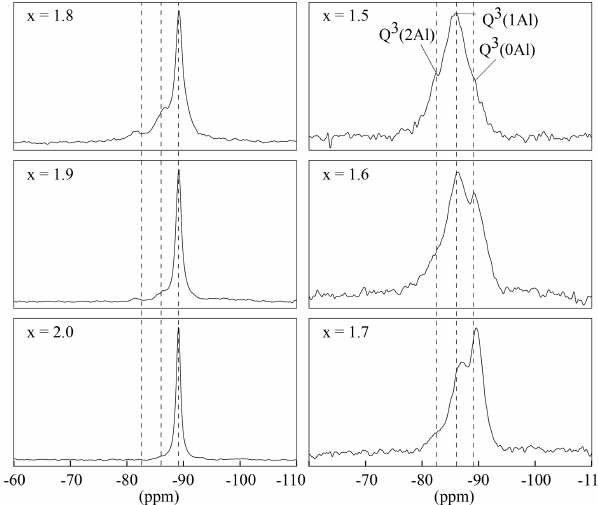
Figure 7. 29 Si MAS NMR spectra with different x content (1.5 to 2.0) and constant OH content with y = 0 . 8. The polylithionite shows one defined signal for the Q 3 (0Al) environment. The second, belonging to the Q 3 (1Al) environment, and the third signal, belong- ing to the Q 3 (2Al) environment, appear and increase with decreas- ing Li content. The position of the signals is marked by the dashed